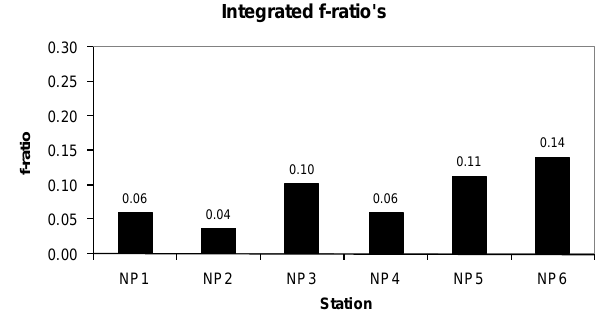
Fig. 9. Integrated f-ratios calculated from integrated euphotic zone (1% for NP1 and NP6, 0.1% for NP2–NP5) uptake rates for the six productivity stations of the Southbound Figure 9. Thomalla et al.